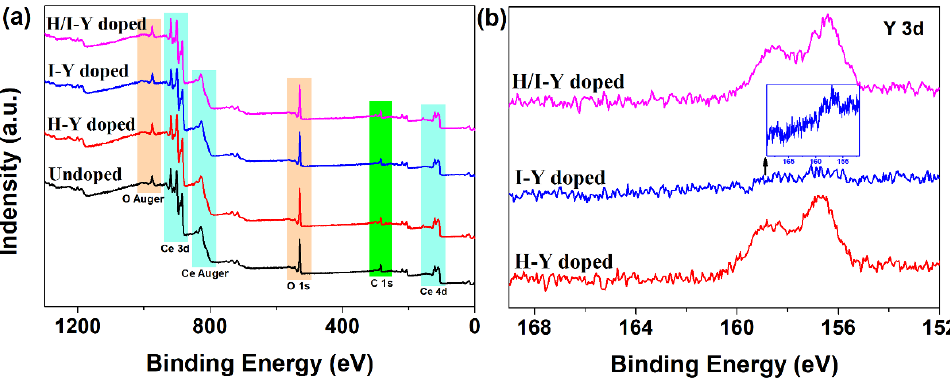
Figure 3. ( a ) Wide-scan XPS spectra of Undoped and H-Y-, I-Y-, and H/I-Y-doped CeO 2 and ( b ) the corresponding XPS regions of Y 3d for H-Y-, I-Y-, and H/I-Y-doped CeO 2 (the inset in Figure 3b is an independent drawing of the Y 3d XPS region for I-Y-doped CeO 2 ).